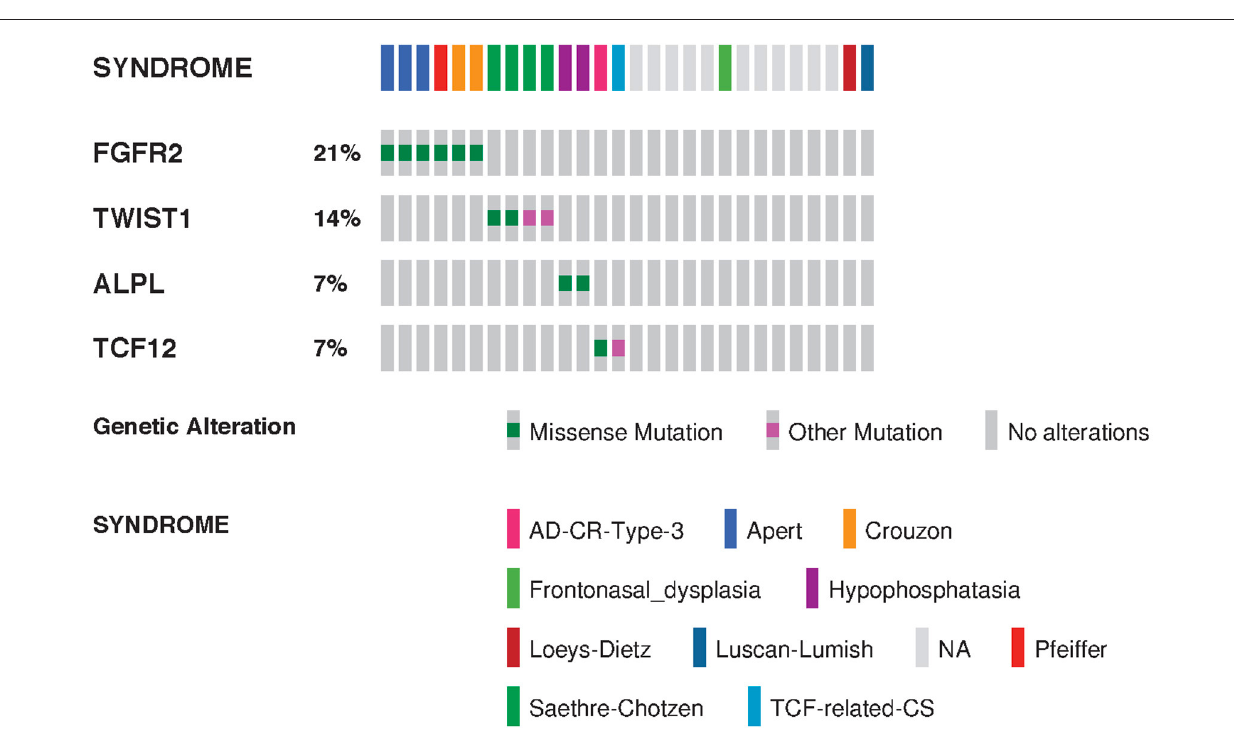
FIGURE 4 | Summarized visualization of the genes mutated in craniosynostosis cohort. Data is shown for Craniosynostosis cohort of 28 patients. Columns are clustered by syndrome type where each column represent one sample. Type of genomic event and syndrome are color coded. Only variants classified as pathogenic or likely pathogenic are